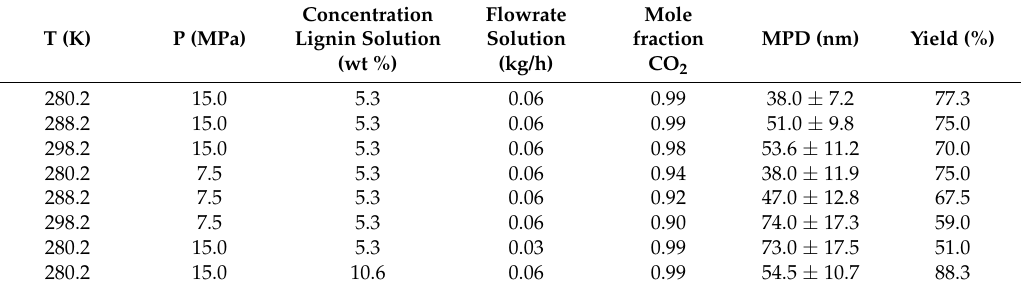
Table 2. Mean particle diameter and precipitation yields with variation of Temperature, Pressure, initial lignin solution concentration and solution flowrate. Adapted from Myint et al. [135] with permission of The Royal Society of